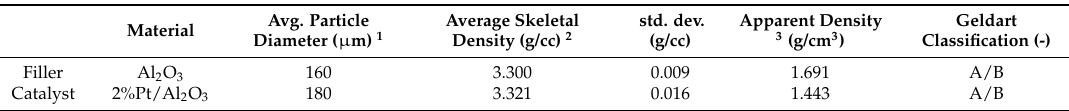
Table 4. Catalyst and alumina particles physical properties.